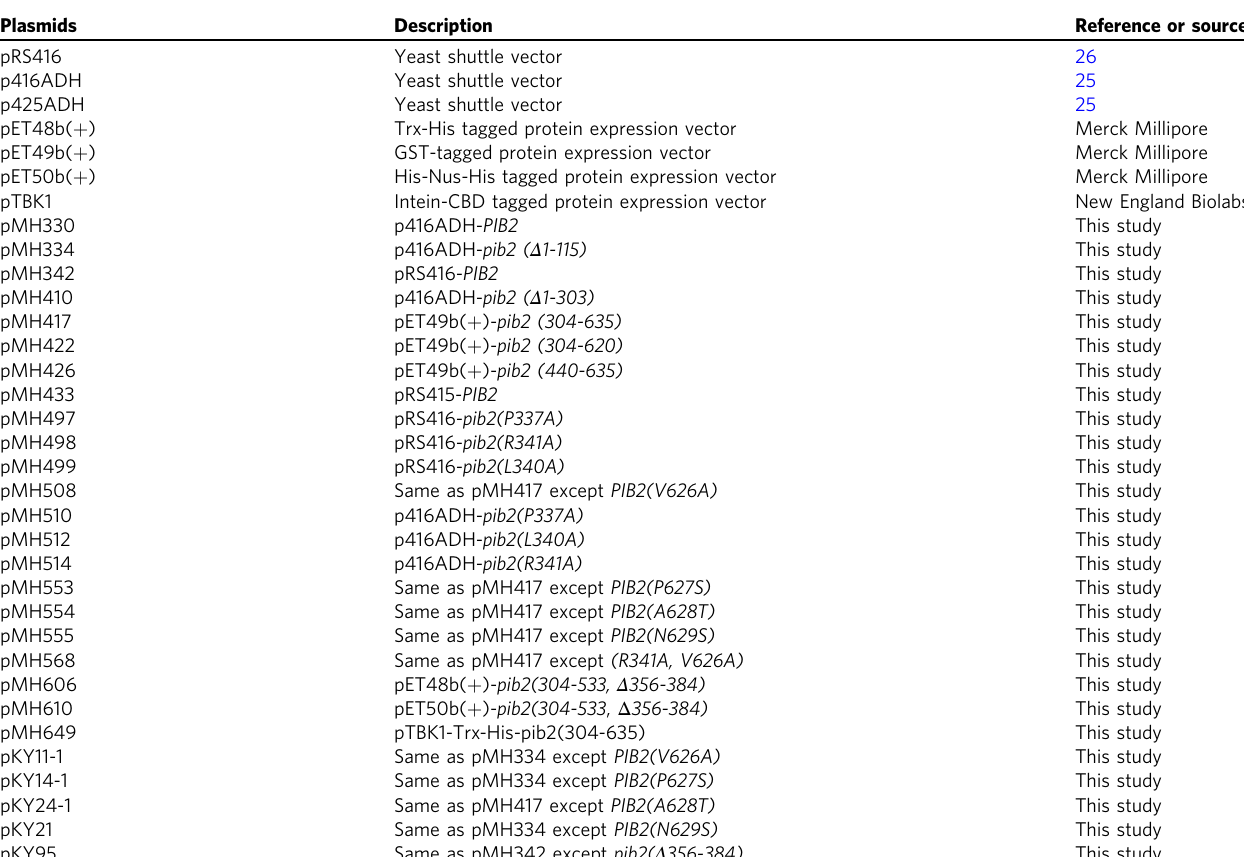
Table 2 Plasmids used in this